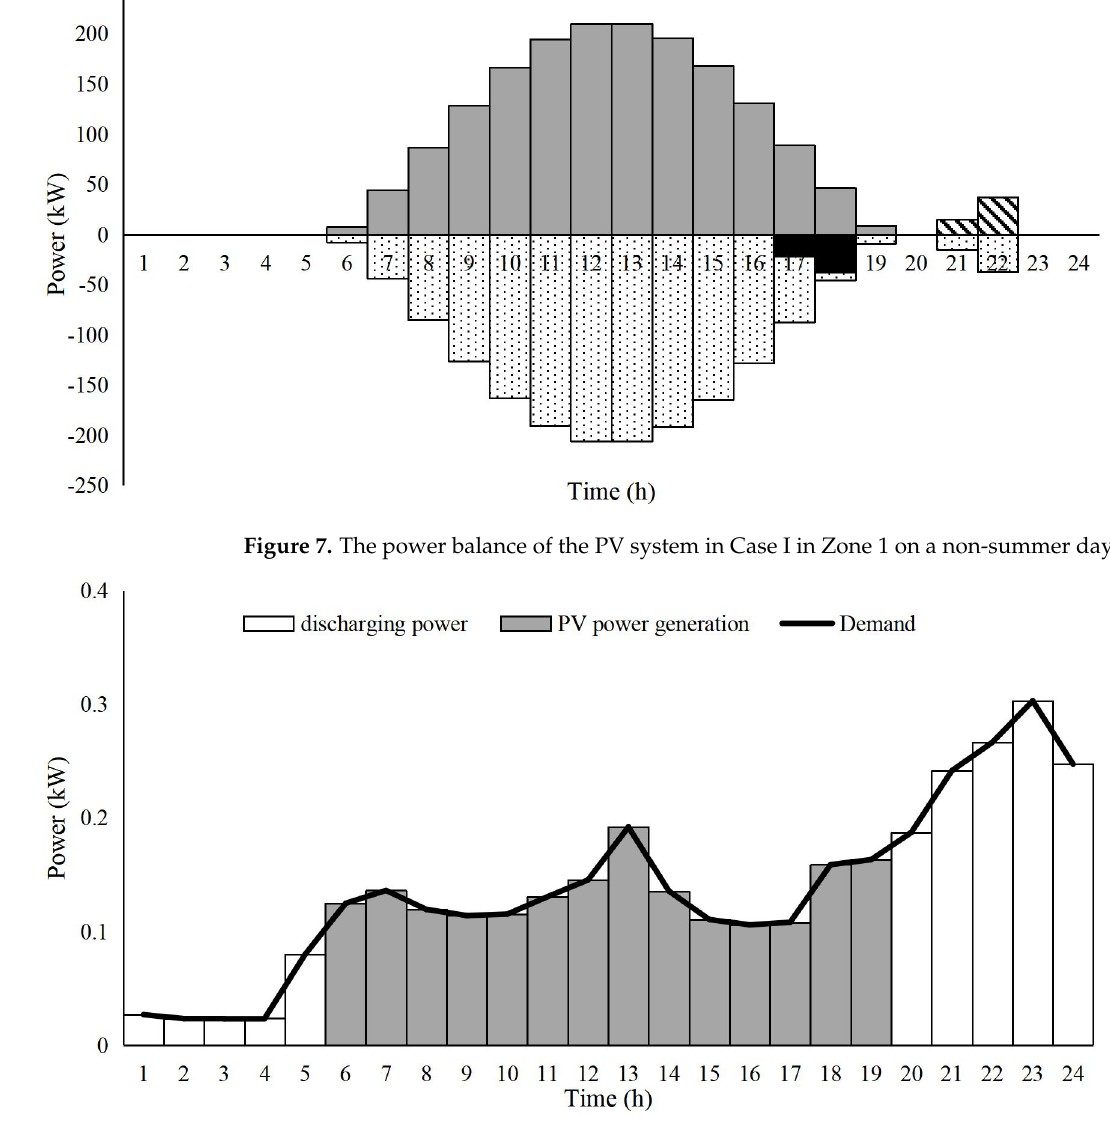
Figure 8. Results of supplying the demand for Case I in Zone 1 on a non-summer day. Table 10. The details of the costs/revenue in case